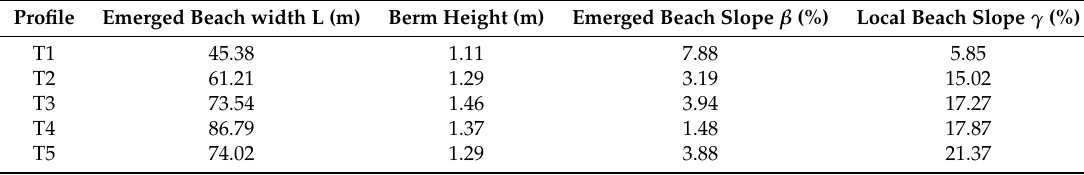
Figure 1. Serapo beach study area ( a ) with the location of the beach video camera system (red star) and the five investigated cross-shore transects (red lines), obtained by a beach survey conducted in September 2017; the beach profile along the transect with the location of the anthropic structures (black trapezium), Mean Sea Level (MSL), and the Mean Spring Tidal Range (MHSW), extracted by the official Italian tide archives (http://www.mareografico.it, last access: 30 April 2019) was reported for T1, T2, T3, T4, and T5. (basemap c (cid:13) 2018 Google product). Table 1. Summary of Serapo beach’s morphological characterization. The reported parameters are relative to the beach cross-shore profiles